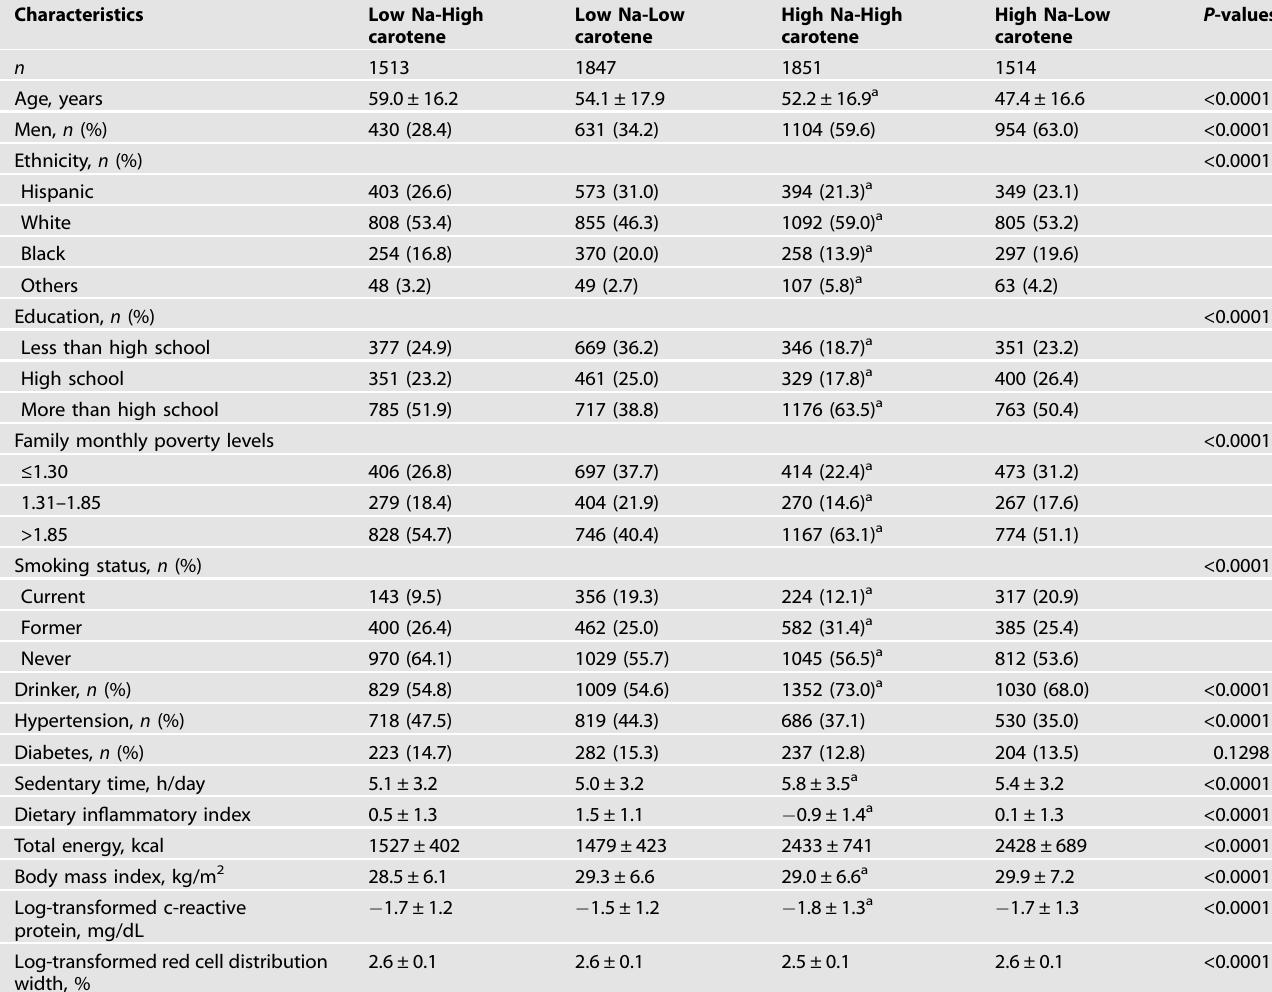
Table 1. Characteristics of the study population by combinations of dietary sodium and β -carotene intakes ( n = 6725).